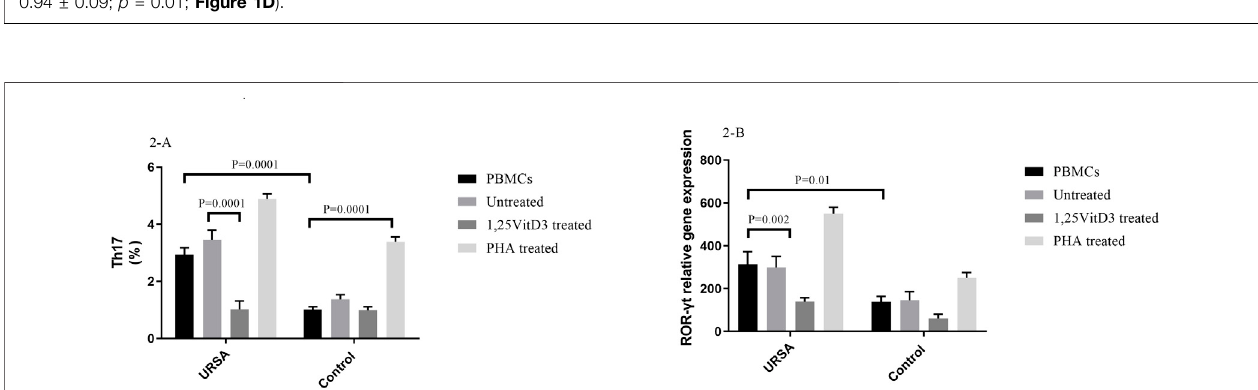
FIGURE 2 | Frequency of Th17 cells and ROR- γ t gene expression in URSA and control groups. (A) . The proportion of Th17 cells in PBMCs of women with URSA cells were signi fi cantly higher compared to the control group. In PBMCs of women with URSA, the percentage of Th17 cells decreased after treatment with 1,25VitD3 relative to untreated PBMCs (B) . ROR- γ t gene expression was higher in PBMCs of women with URSA than in PBMCs of controls. Treatment with 1,25VitD3 decreased ROR- γ t gene expression at the mRNA level relative to untreated PBMCs in women with